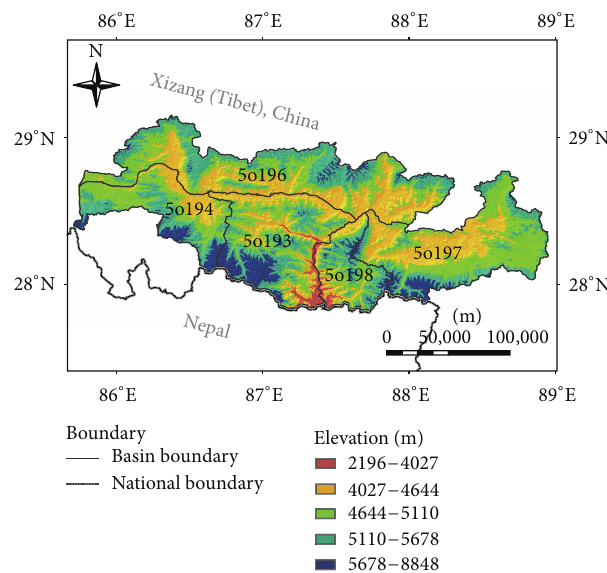
Figure 1: Location of the Pumqu river basin and its